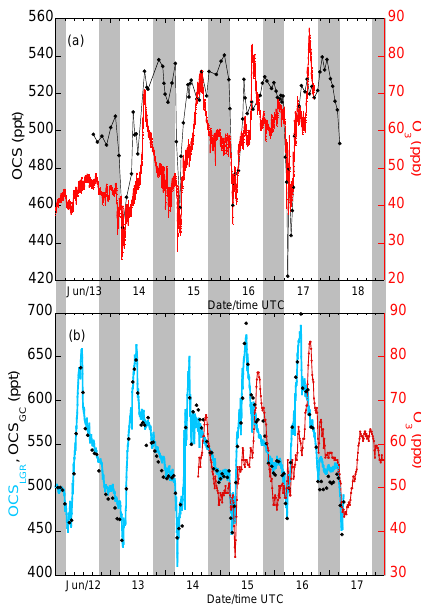
Figure 3. Diel variations in OCS and O 3 mixing ratios at O3HP in June 2012 (a) and June 2013 (b) . In June 2013, two OCS analyzers were run in parallel and O 3 was measured a few hundred meters from the main O3HP site. The LGR analyzer was calibrated against the GC, OCS LGRcal . = 1 . 14 × OCS LGRraw + 12 . 3ppt. O 3 data were downloaded from the regional air quality network Air-Paca, France (http://www.airpaca.org/).